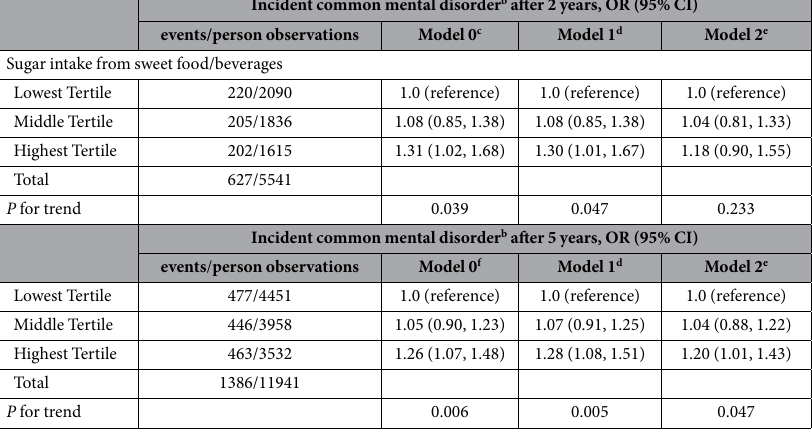
Supplementary Table S2) and exclusion of person observations with extremely high sugar intakes did not affect the results. In men and women, no association between sugar intake from sweet food/beverages and incident depression or clinical depression 5 years later was observed (Model 0, highest vs. lowest tertile OR, depression 0.92; 95% CI: 0.71, 1.18; P for tertile trend = 0.44; clinical depression: 0.95; 95% CI: 0.51, 1.75; P for trend = 0.84). The same exposure contrast was not associated with incident CMD or depression caseness after 10 years (Model 0, highest vs. lowest tertile OR: 1.10; 95% CI: 0.92, 1.31; P for tertile trend = 0.31; and 1.17; 95% CI: 0.91, 1.50, P for tertile trend = 0.25, respectively). However, sugar intake was positively associated with incident clinical depression after 10 years in men (Model 2 Person observations = 2572, cases = 35; P for tertile trend = 0.67), but negatively in women (Person observations = 848, cases = 28; P for tertile trend = 0.02). Prospective analyses regarding the associations of sugar intake from sweet food/beverages and recurrent mood disorders showed no evidence for sex interaction for CMD, CES-D depression or clinical depression 5 years later. Sugar intake from sweet food/beverages was positively associated with recurrent depression after 5 years (Model 0, highest vs. lowest tertile OR: 1.81; 95% CI: 1.23, 2.66; P for tertile trend = 0.003, Table 4). The association was attenuated when adjusted for other diet-related factors. Moreover, there was some evidence that sugar intake from sweet food/beverages was associated with recurrent clinical depression in both sexes combined (highest vs. lowest tertile OR: 1.66; 95% CI: 0.96, 2.87 and P for tertile trend = 0.07) when adjusted for age, sex and ethnicity (Supplementary Table S3). This association attenuated when further factors were introduced to the model. No statistically significant association was found for sugar intake from sweet food/beverages and recurrent GHQ caseness after 2 and 5 years (Model 0 for CMD after 2 years, highest vs. lowest tertile OR: 1.05; 95% CI 0.76, 1.45; P for tertile trend = 0.83; for CMD after 5 years: 1.16; 95% CI 0.93, 1.46; P for tertile trend = 0.20). Analyses of recurrent CMD, depression and recurrent clinical depression after 10 years showed no associa- tions with sugar intake from sweet food/beverages. Sensitivity analyses excluding extreme values of sugar intake and excluding person-observations with self-reported doctor diagnosis at baseline attenuated the association of sugar intake from sweet food/beverages and recurrent depression slightly (before P for tertile trend 0.003 after 0.022 and 0.010, respectively). Similarly, associations with clinical depression weakened when participants with depression diagnosis at baseline were excluded (Model 0, Person observations = 573; cases = 78; P for tertile trend = 0.17). Analysis of reverse causation.